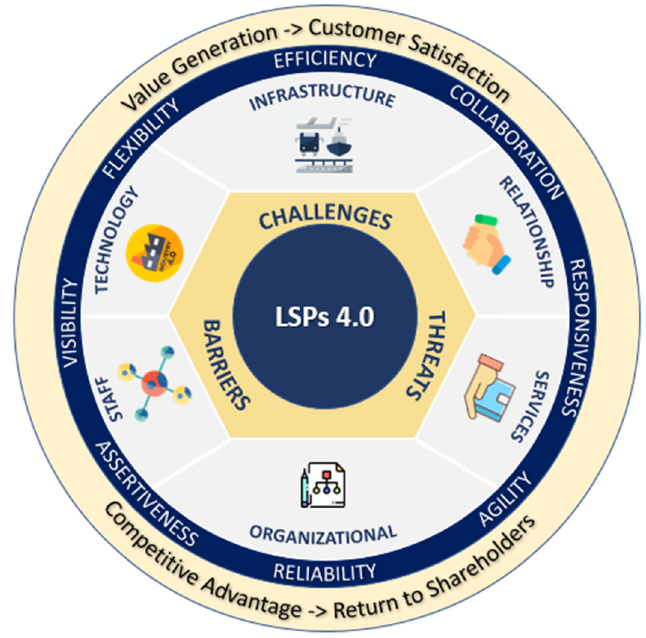
Figure 6. Conceptual map for the logistics service provider 4.0.